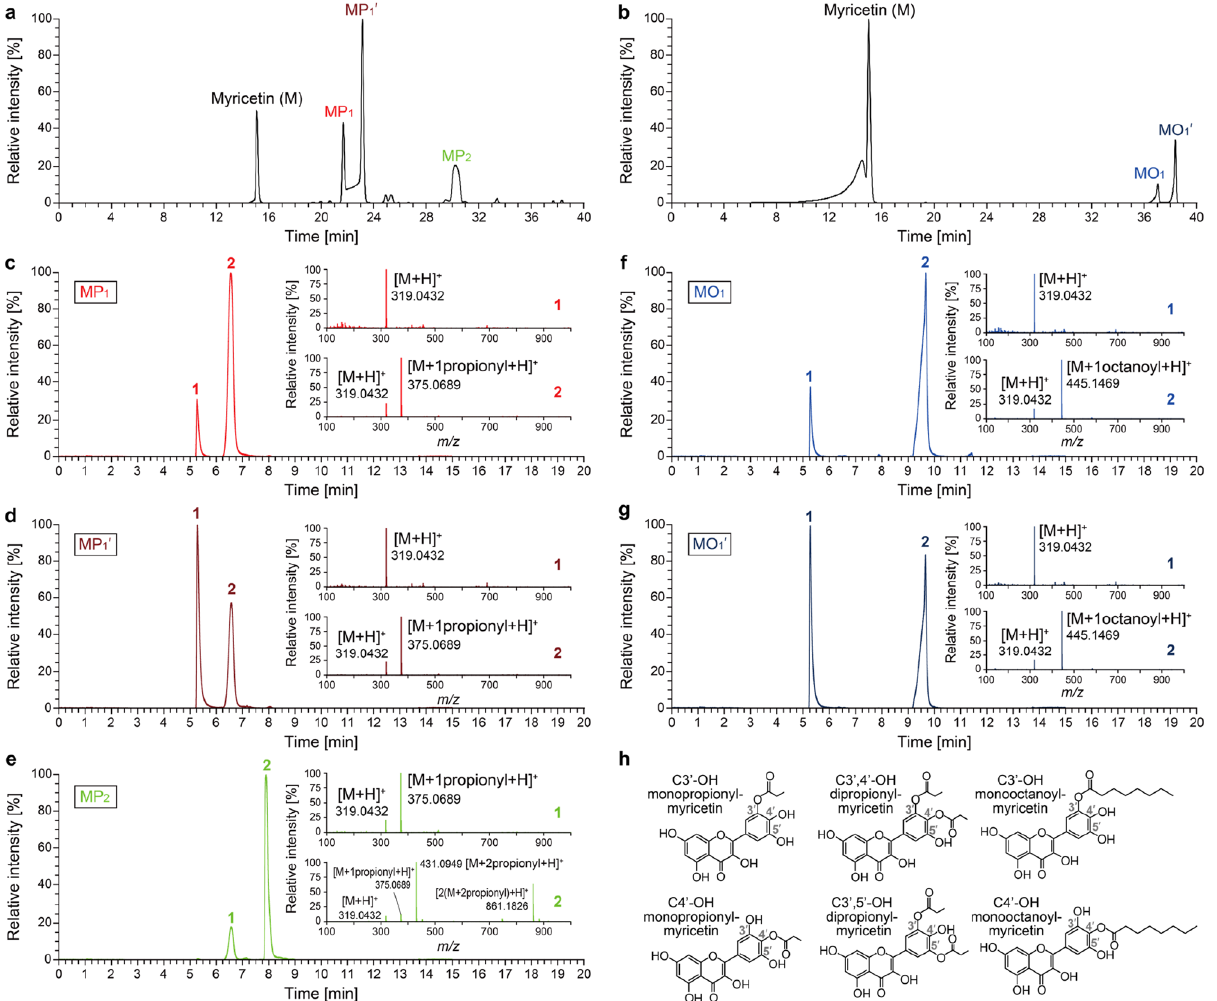
Figure 3. Purification and identification of acylated myricetin products. ( a , b ) Representative preparative HPLC chromatograms of acylated myricetin mixtures for separation. Myricetins were converted to ( a ) propionylated myricetin mixture including MP 1 , MP 1 ′ and MP 2 and ( b ) octanoylated myricetin mixture including MO 1 and MO 1 ′ in the presence of TMA. ( c – g ) UPLC chromatograms and MS/MS spectra for identification of separated acyl myricetins: ( c ) MP 1 , ( d ) MP 1 ′ , ( e ) MP 2 , ( f ) MO 1 , and ( g ) MO 1 ′ . UV/Visible chromatograms were obtained at wavelength 374 nm and positively electrospray-ionized mass ( m/z ) spectra for each fraction are shown (inset). ( h ) Determined structures of C3 ′ -OH monopropionyl-myricetin, C4 ′ -OH monopropionyl-myricetin, C3 ′ ,4 ′ -OH dipropionyl-myricetin, C3 ′ ,5 ′ -OH dipropionyl-myricetin, C3 ′ -OH monooctanoyl-myricetin, and C4 ′ -OH